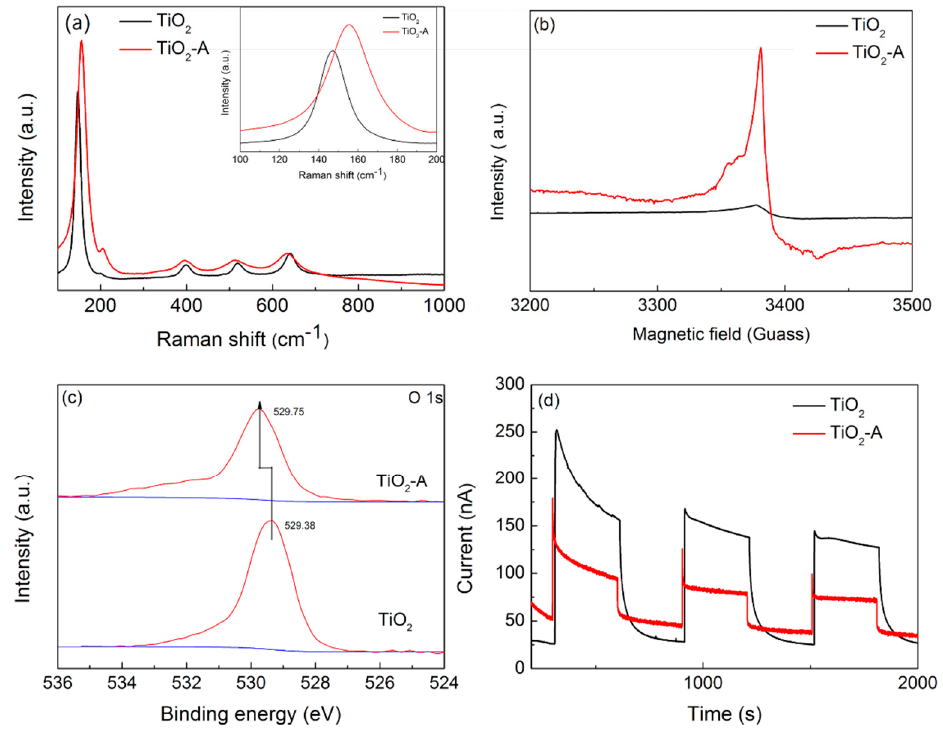
Figure 2. TiO 2 and TiO 2 -A: ( a ) Raman spectra, inset was the locally magnified Raman spectra (100–200 cm − 1 ); ( b ) EPR spectra; ( c ) O 1s XPS spectra; ( d ) photocurrent result.